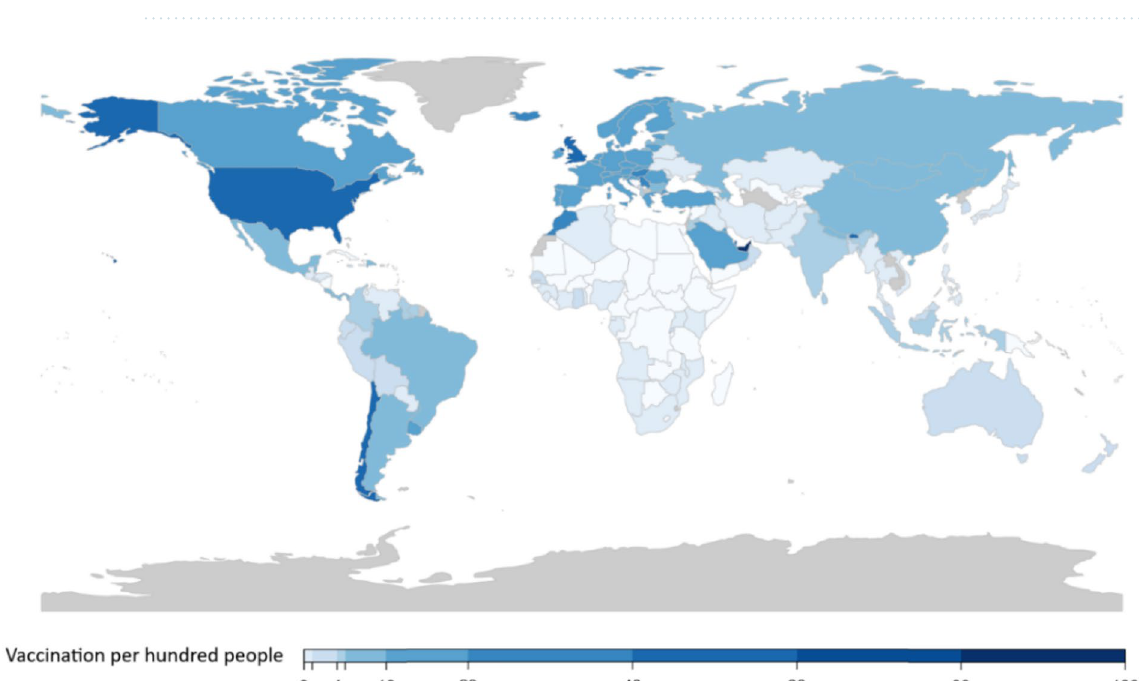
Figure 2. COVID-19 Vaccination per Hundred People Approximately Three Months After the First Public COVID-19 Vaccination (by March 31, 2021). Darker blue shows higher vaccination rates per hundred people. Countries with no available data are shown in gray. The maps were generated using RStudio 4.0.2 (R Core Team, 2020). Downloaded from: https:// www. rstud io. com/ produ cts/ rstud io/ downl